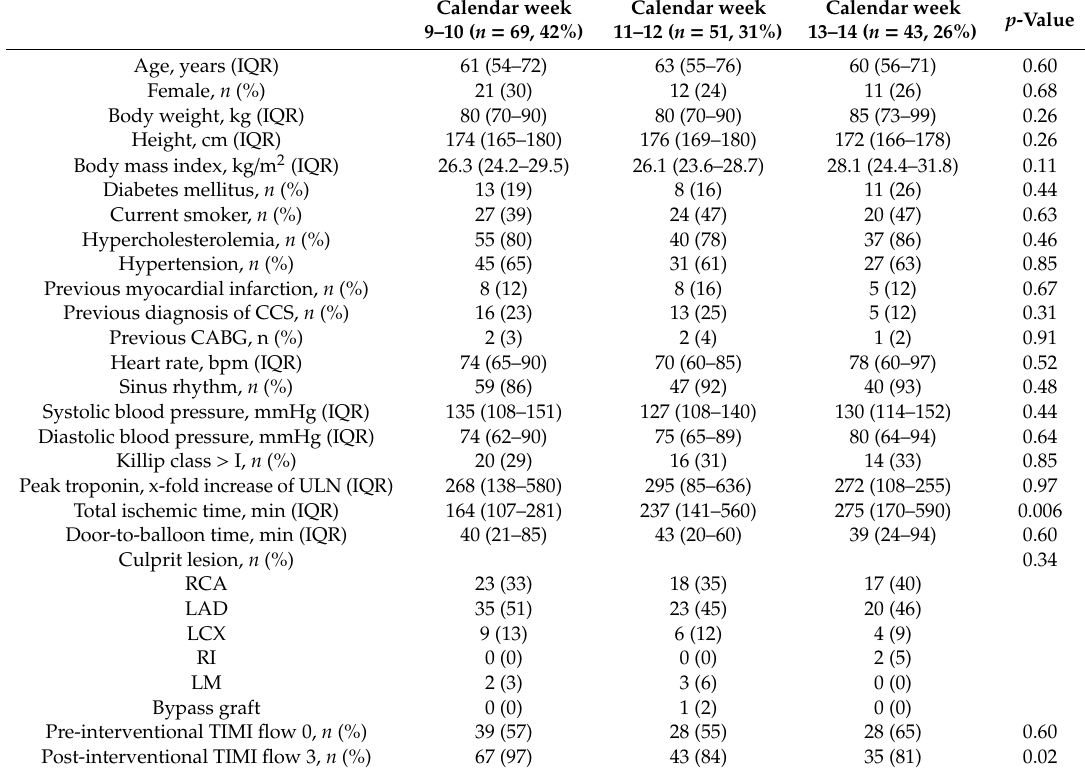
Table 2. Di ff erences in patient characteristics during the COVID-19